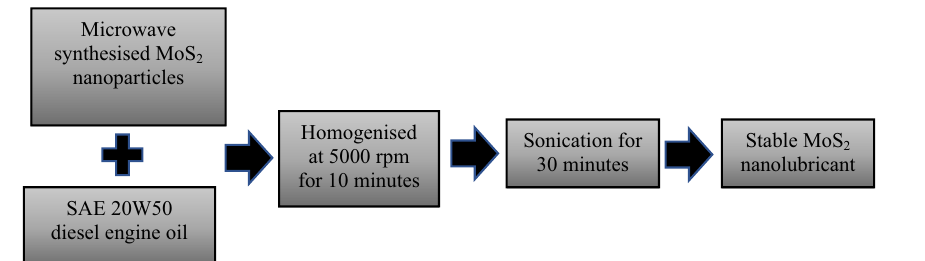
Figure 12. Process flow of MoS 2 nanolubricant